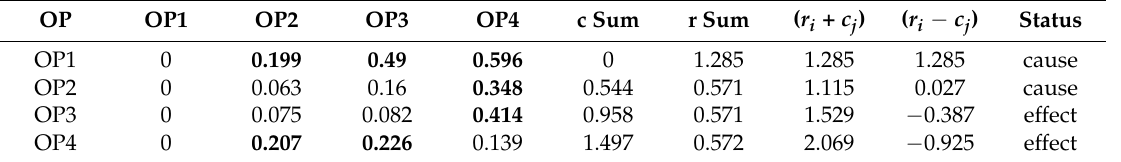
Table 6. The total relation matrix for operation FMs.